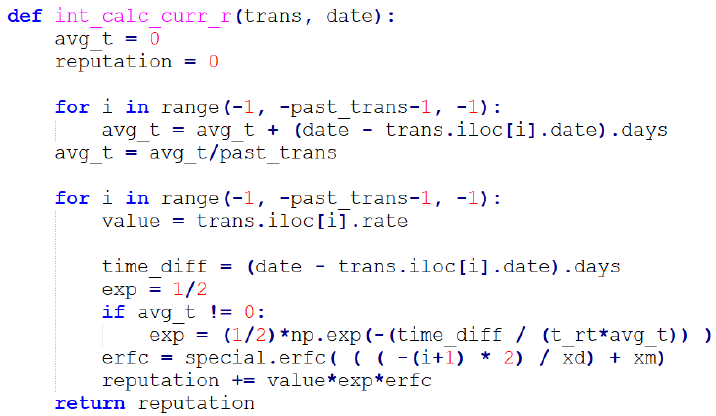
Figure 4. An implementation of the function that calculates Cardholder’s Reputation.